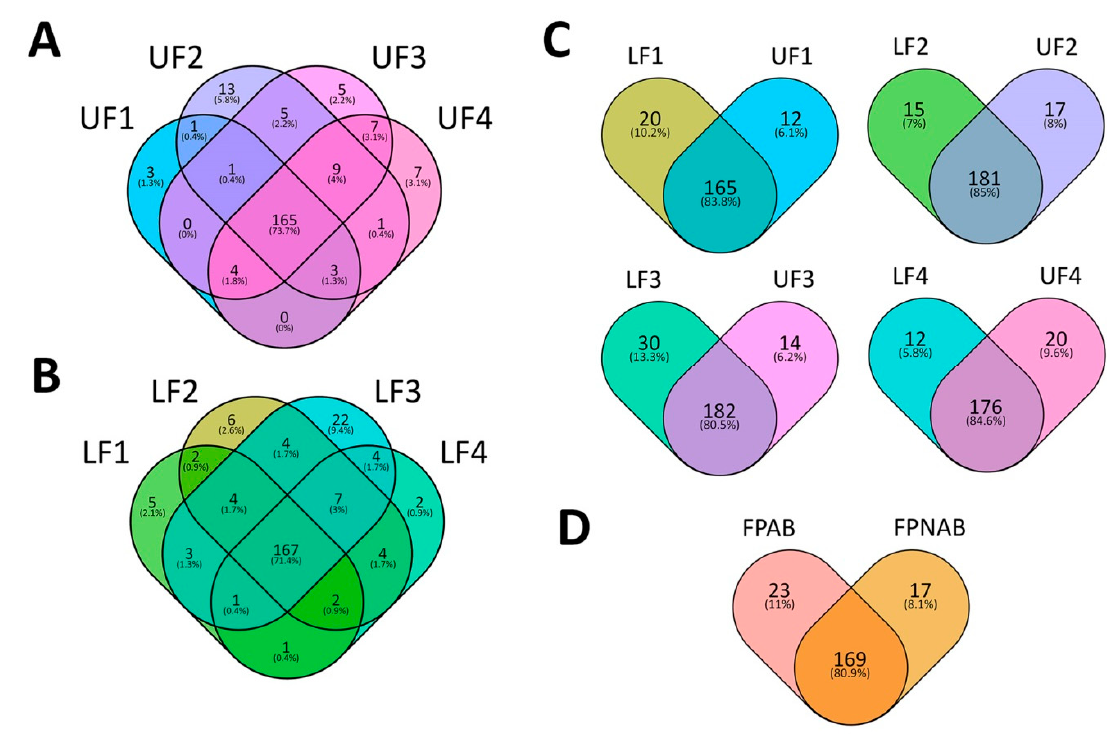
Figure 6. Diagrams showing distribution of yellow lupine miRNAs in ( A ) upper flowers, ( B ) lower flowers, ( C ) both upper and lower flowers at particular stages of their development, ( D ) pedicels of abscising flowers or flowers maintained on the plant.